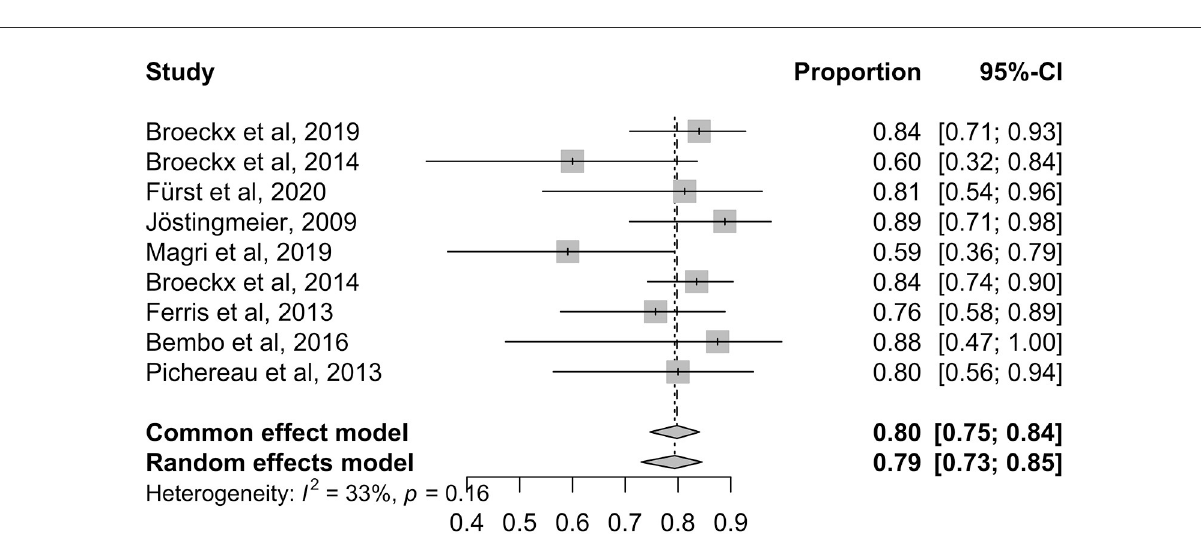
random effects model. As demonstrated in the last row of the plot, all long-term follow-up studies showed moderate heterogeneity with I 2 = 55% and p = 0.11 (Figure 6). A random effects model was used due to the assumption of moderate differences among study design and implementation in the clinical studies. An odds ratio (OR) of 1 indicates no difference between the treatment and control group, whereas an OR > 1 indicates that lameness is more likely to be reduced in the experimental group. All studies with an OR values higher than 1 favor the experimental group (Figure 6: OR 17.02; 95% CI: 8.5474 to 33.8849 p < 0.0001).